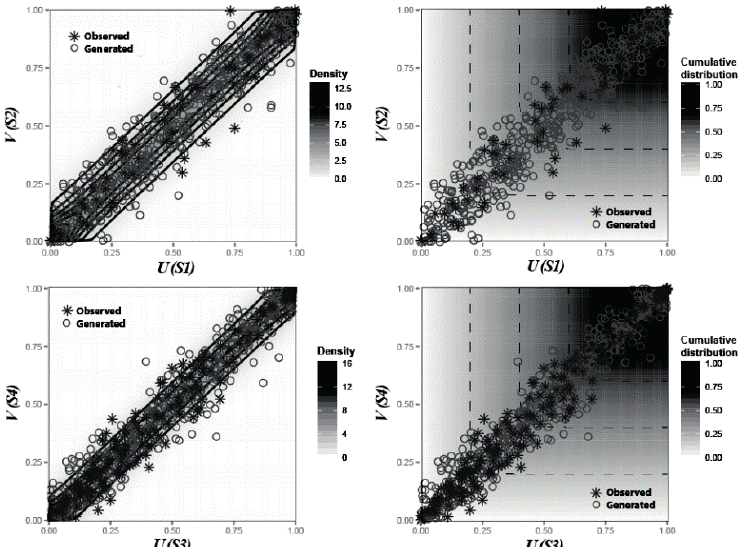
Fig. 3 Scatterplots of the observed and generated data with the POME-Frank copulas.